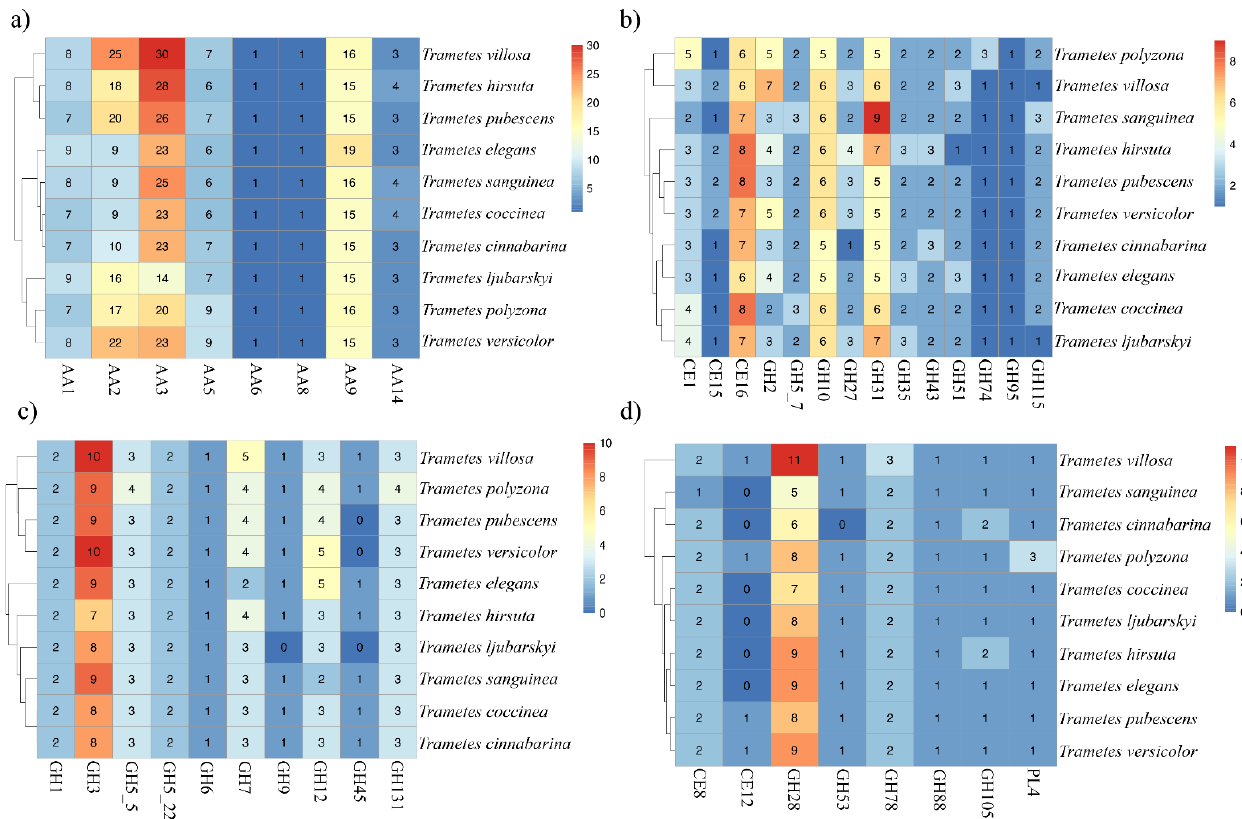
Figure 5. CAZyme-encoding genes involved in the degradation of lignocellulosic biomass. ( a ) Number of auxiliary redox enzyme-encoding genes. ( b ) Number of hemicellulose-degrading enzyme-encoding genes. ( c ) Number of cellulose breakdown enzyme-encoding genes. ( d ) Number of pectin-degrading enzyme-encoding genes.